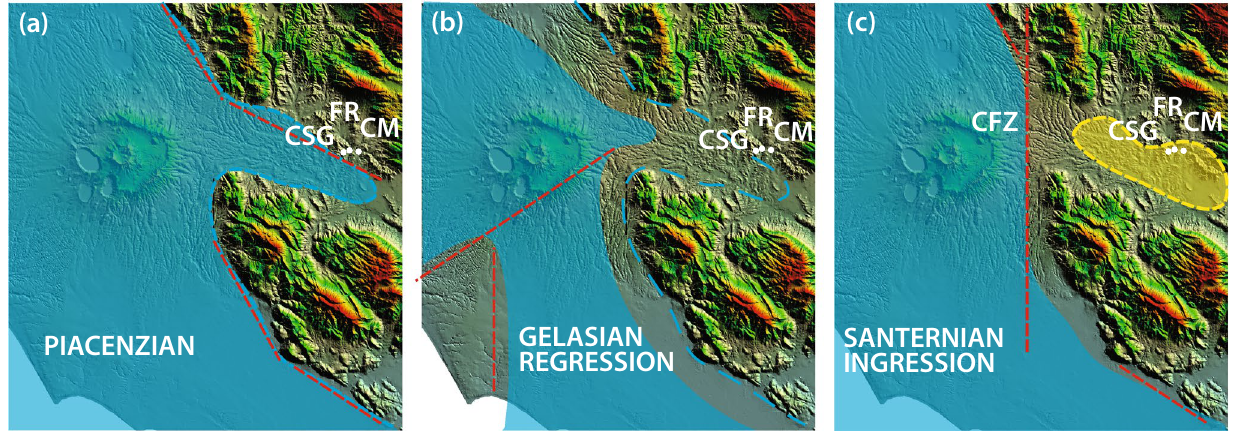
Figure 10. Paleogeographic sketches showing the sea ingression and regression phases occurring in the investigated area 2.5 Ma through 1.8 Ma. See text for explanations. DEM images used with permission of